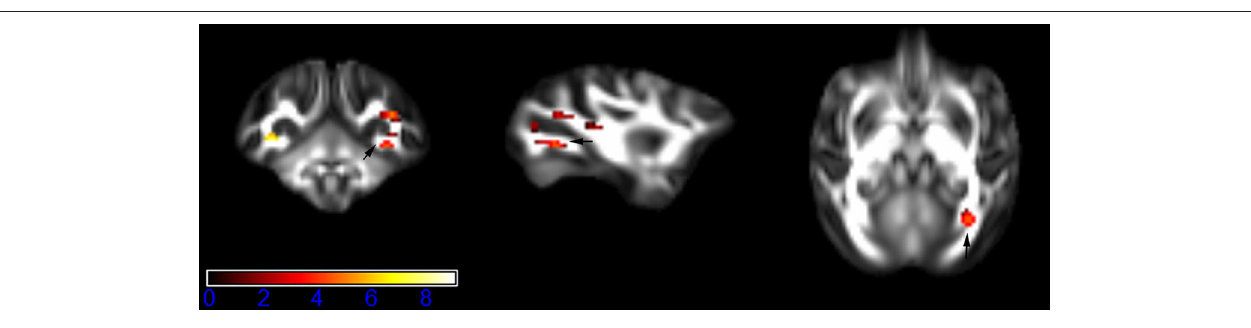
FIGURE 1 | Areas in sagittal striatum (SS, right side) with reduced fractional anisotropy values in the chronic ketamine exposure group compared to controls at p < 0.005 (in red; uncorrected). The anatomical underlay is DTI-based monkey brain image template (UWRMAC-DTI271) FA map with white matter atlas. Figure from left to right side is coronal view, sagittal view, and axial view of the images, respectively. The color bar represents the t -value.